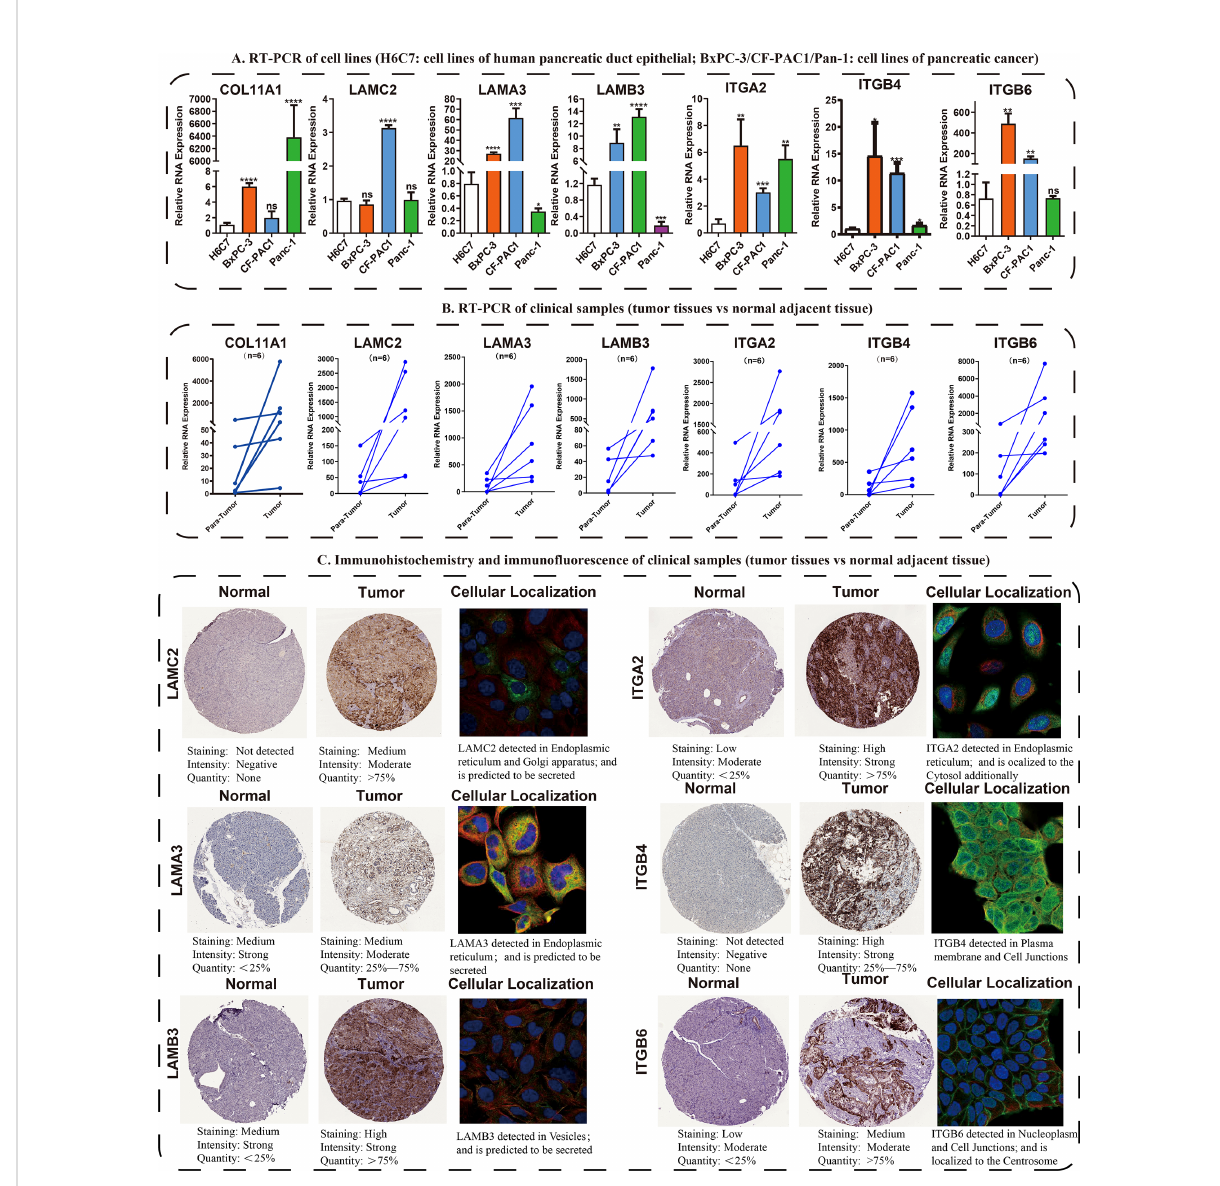
FIGURE 4 Validation of the expression traits of seven hub ECMGs. (A) RT-PCR of cell lines (H6C7: cell lines of human pancreatic duct epithelial; BxPC-3/CF-PAC1/ Pan-1: cell lines of pancreatic cancer). (B) RT-PCR of clinical samples (tumor tissues vs normal adjacent tissue). (C) Immunohistochemistry and immuno fl uorescence of clinical samples (tumor tissues vs normal adjacent tissue). (* indicates p <0.05; ** indicates p < 0.01; *** indicates p < 0.001; **** indicates p < 0.0001; ns, non-signi fi